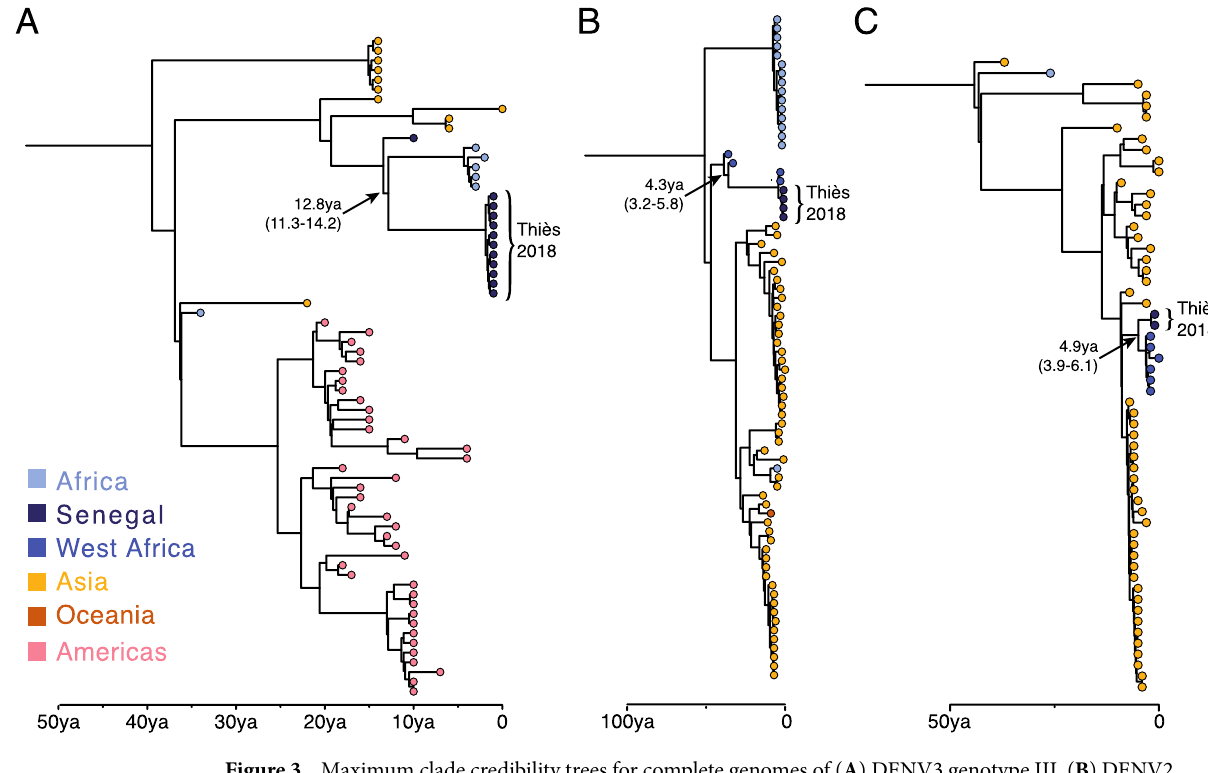
Figure 3. Maximum clade credibility trees for complete genomes of ( A ) DENV3 genotype III, ( B ) DENV2 Cosmopolitan genotype and ( C ) DENV1 genotype III. BEAST analysis was performed on the complete CDS from 136, 188 and 118 genomes for DENV1, DENV2 and DENV3, respectively. Estimated date and 95% posterior densities are given for nodes of interest described in the (Table 1). No clinical signs or symptoms were found to be differentially reported between presumptive dengue cases and dengue-negative febrile individuals. Headaches were the most common sign reported by all partic- ipants (197/198 participants including all presumptive dengue cases). Among participants with presumptive dengue fever, 89% (17/19) reported muscle aches and 79% (15/19) reported back aches. However, neither was significantly more common among these individuals, even after excluding individuals with a known malaria diagnosis (N = 36) (Table 1).